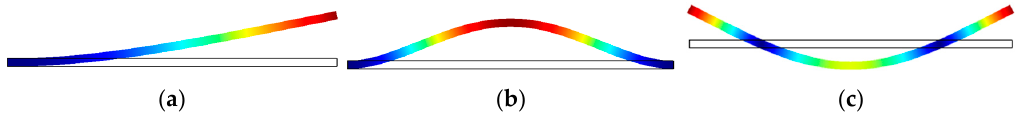
Figure 4. Common flexural mode beams classified according boundary conditions: ( a ) cantilever, β = 0.16154; ( b ) clamped-clamped beam, β = 1.02792; ( c ) free-free beam, β = 1.02792.